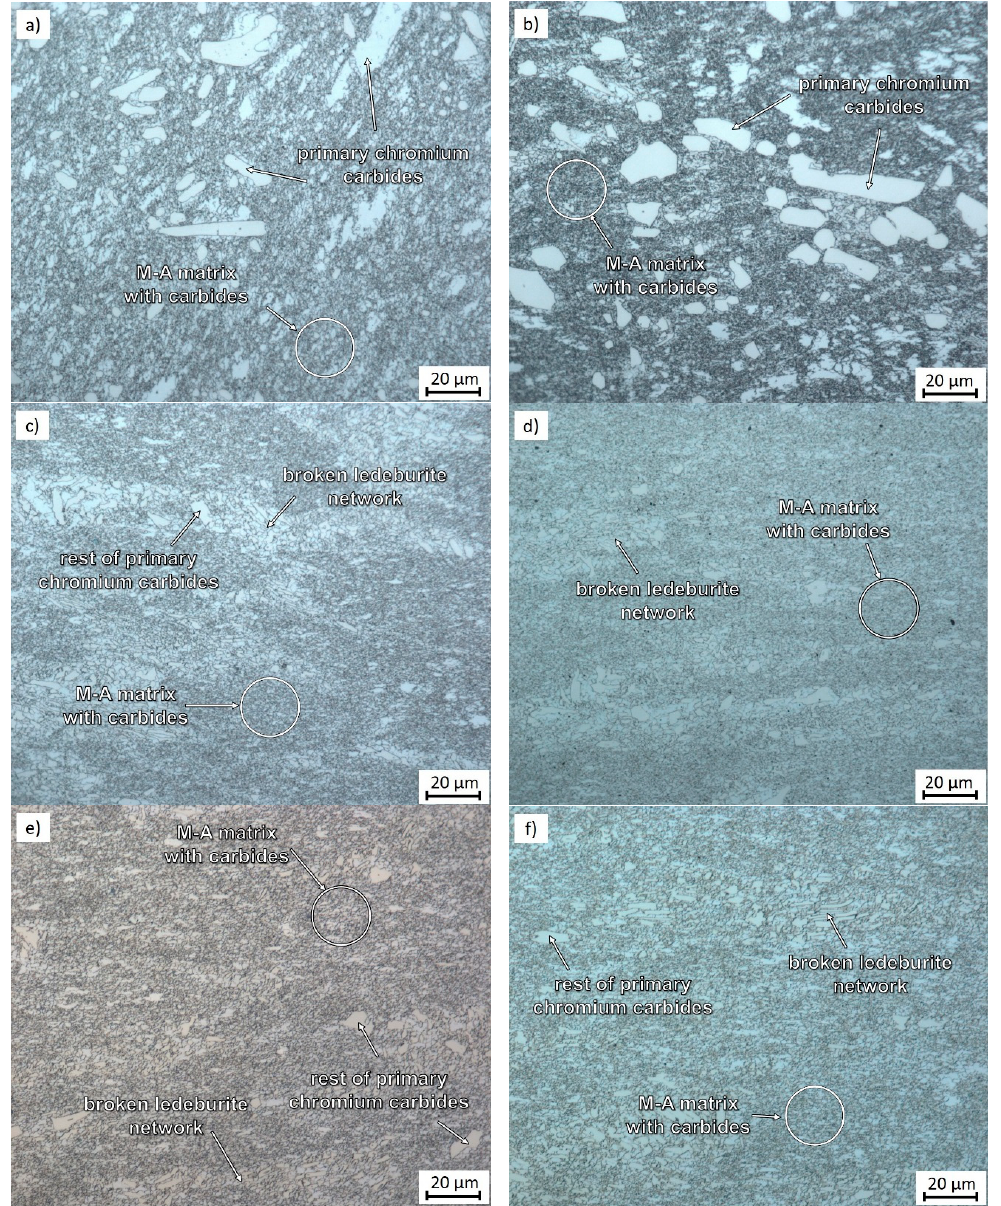
Figure 6. Micrographs from light microscope of semi-solid-processed and subsequently press-formed material: ( a ) 1200 °C/water (regime 1); ( b ) 1220 °C/water (regime 2); ( c ) 1240 °C/water (regime 3); ( d ) material: ( a ) 1200 ◦ C/water (regime 1); ( b ) 1220 ◦ C/water (regime 2); ( c ) 1240 ◦ C/water (regime 3); 1280 °C/water (regime 4); ( e ) 1240 °C/oil (regime 5); ( f ) 1240 °C/oil–250 °C/60 min (regime 6), light ( d ) 1280 ◦ C/water (regime 4); ( e ) 1240 ◦ C/oil (regime 5); ( f ) 1240 ◦ C/oil–250 ◦ C/60 min (regime 6), micrographs. light